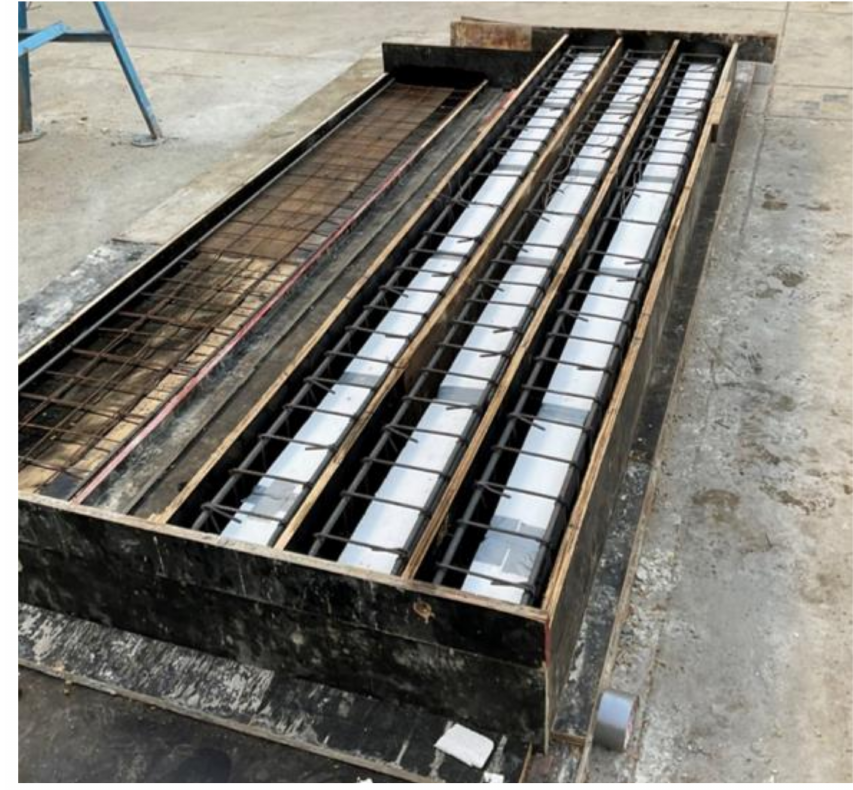
Figure 5. Installation of steel bars in